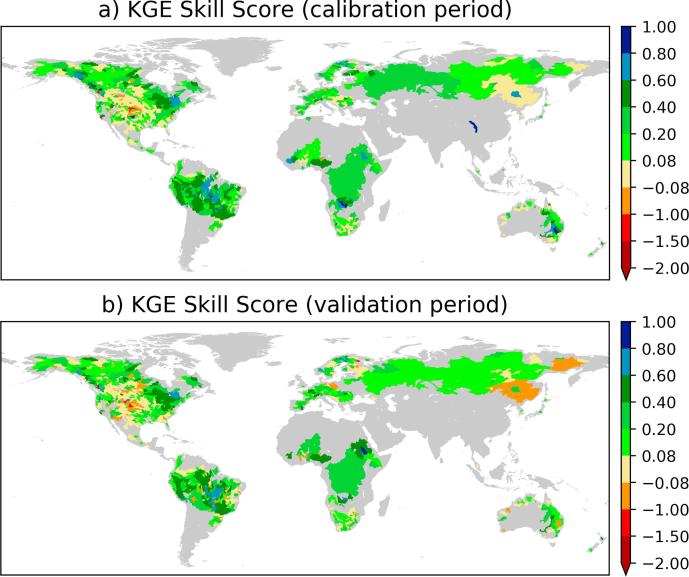
The KGE skill score during calibration (top) and validation (bottom) periods.